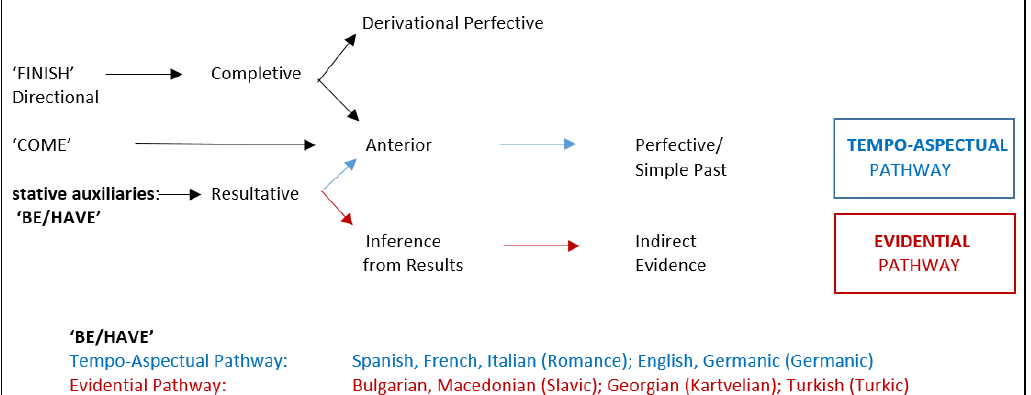
Figure 1. Grammaticalization Pathways of the Perfect